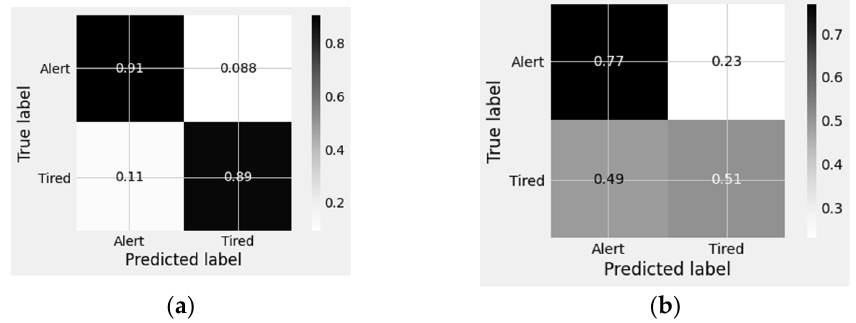
Figure 16. Confusion Matrix of The Proposed Deep Learning Model for Binary Classification ( a ) iD CNN. ( b ) C-CNN.